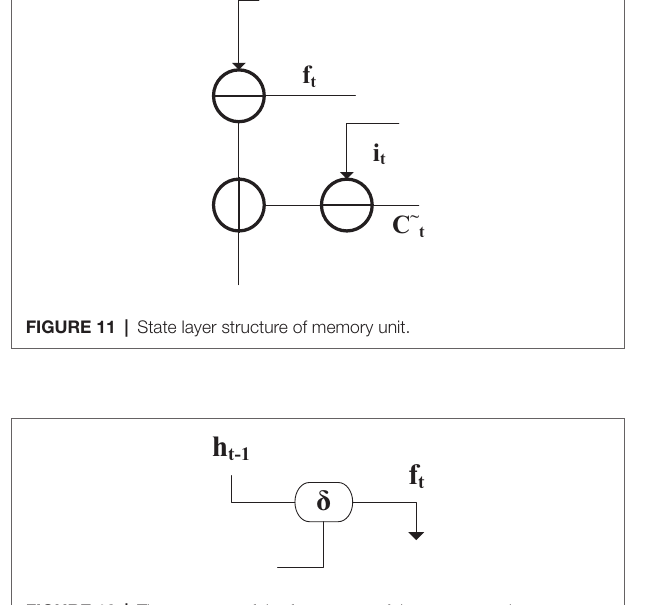
FIGURE 12 | The structure of the forget gate of the memory unit.